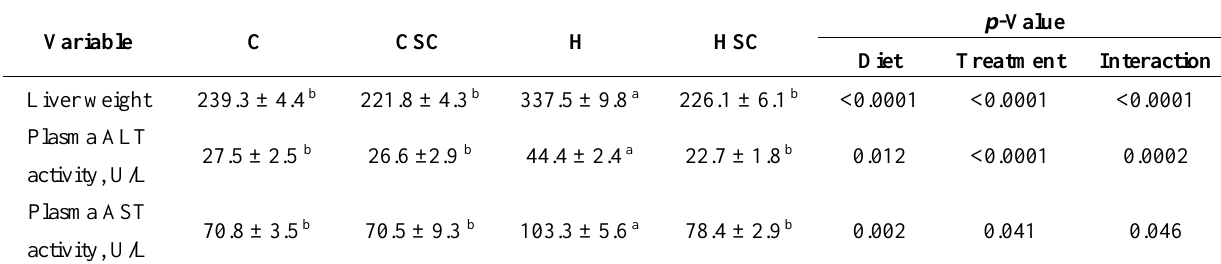
Table 4. Liver variables in C, H, CSC and HSC